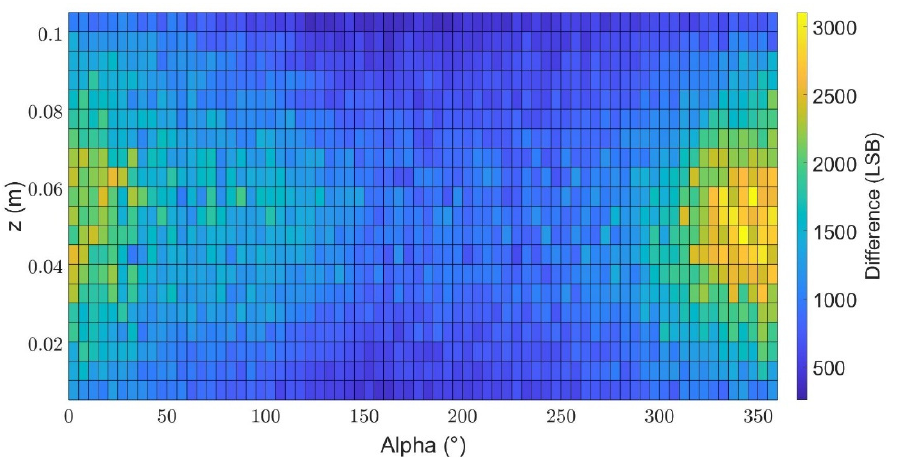
Figure 9. Scalar field of the differential vector size (cid:3630)𝒃 (cid:3045)(cid:3032)(cid:3033) (α, Z, R)(cid:3630) size in the motor surroundings. R = 60 mm.